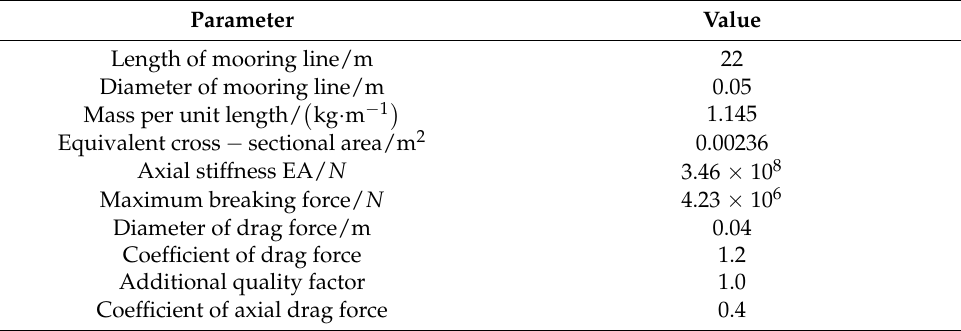
Table 3. Mooring system